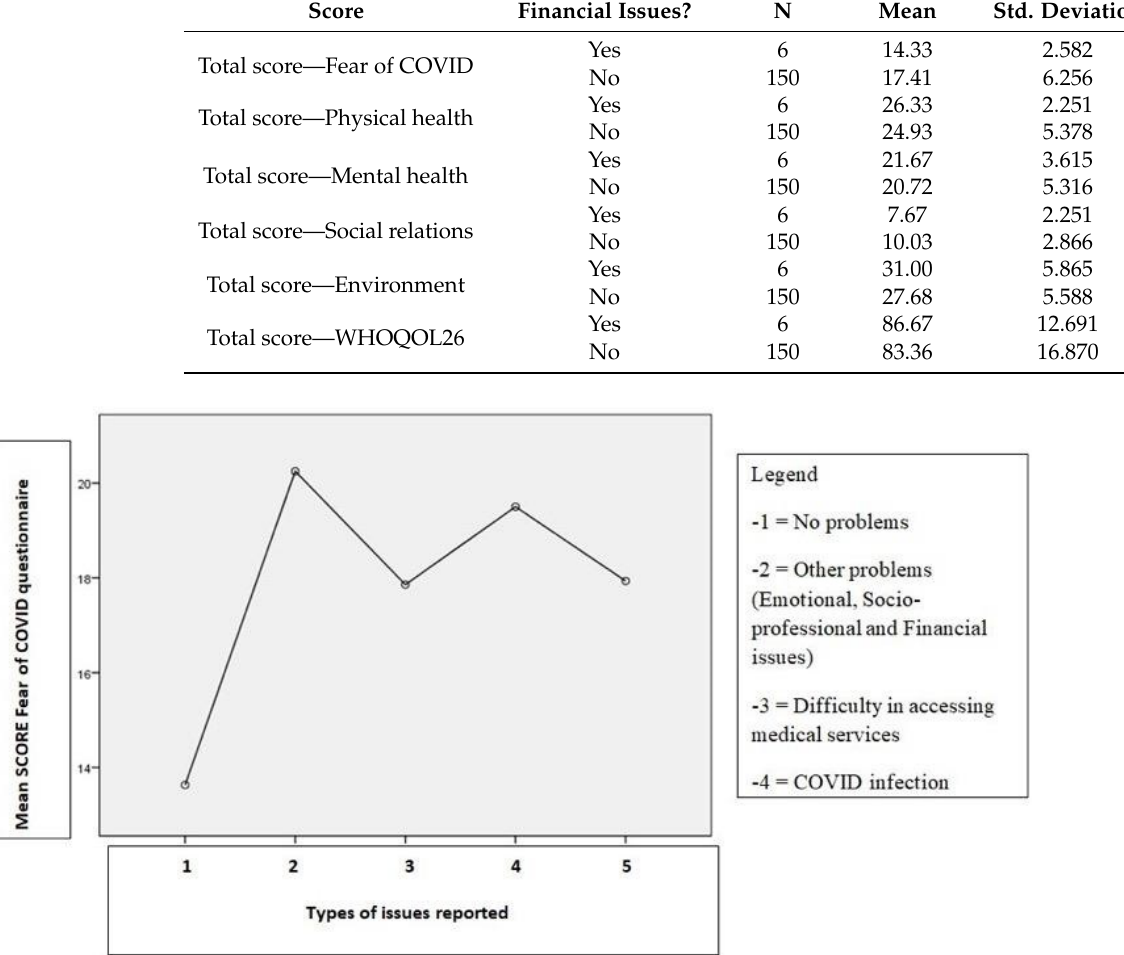
Table 6. Cross-reference between the total scores of participants reporting financial issues.